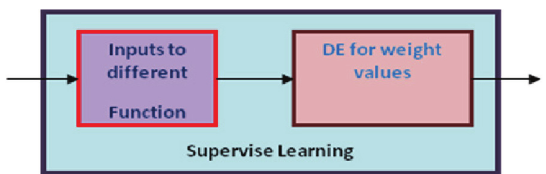
Figure 4: Two step learning